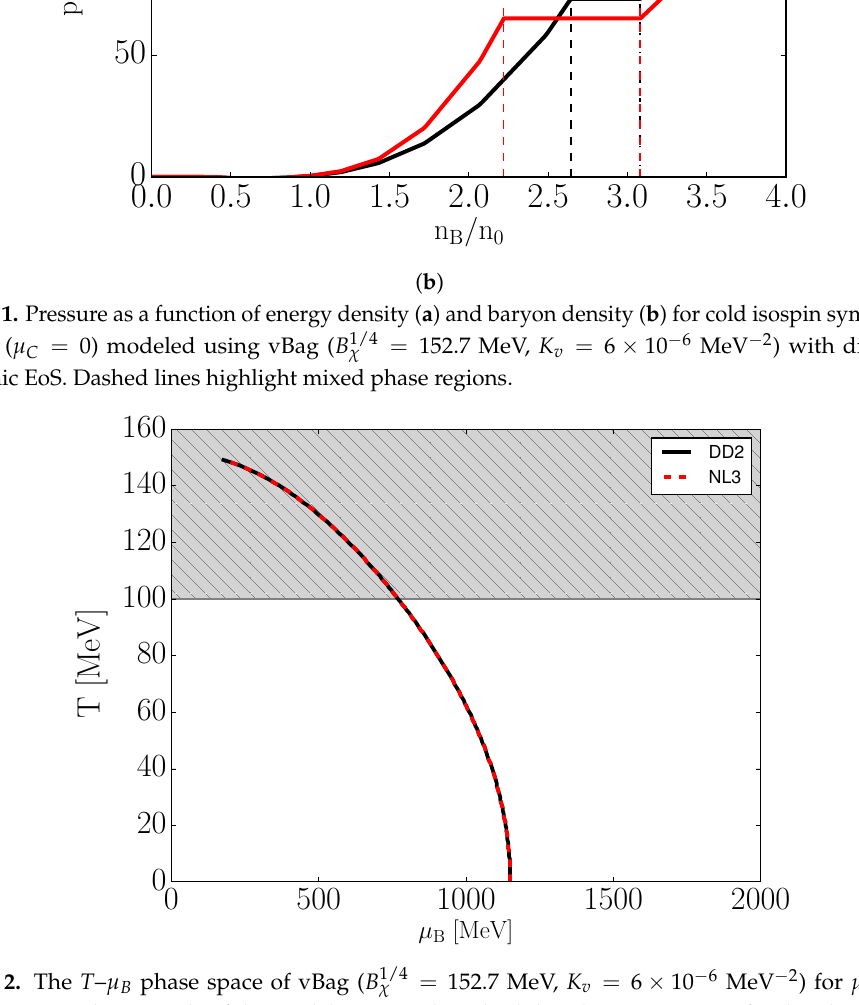
10 − 6 MeV − 2 ) for µ C = 0. ×